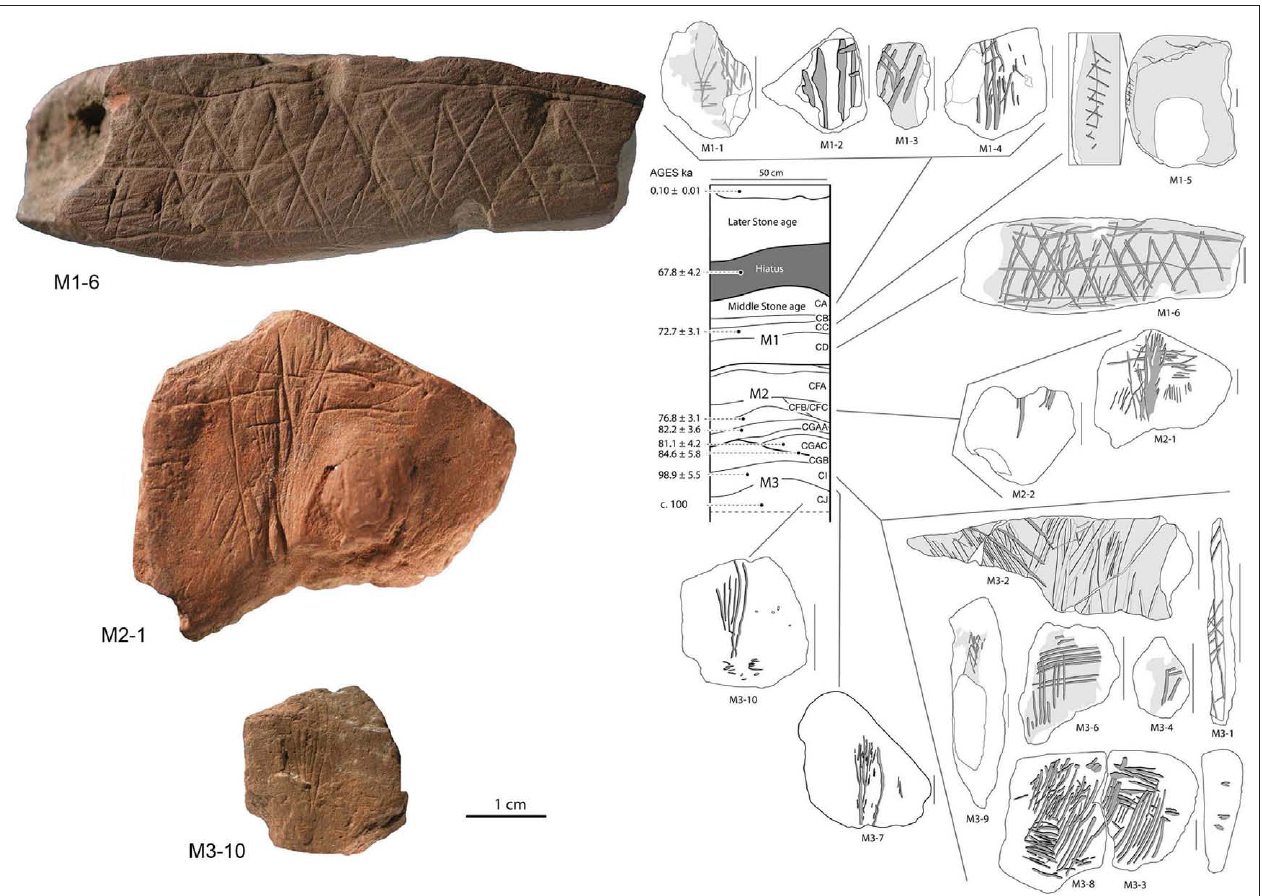
Figure 5 | Middle Stone Age engravings from South Africa. Photos and tracings of pieces M3-10, M2-1, and M1-6 from the Blombos Cave. In the drawing of the center is shown the stratigraphy and ages of Blombos Cave deposits. Adapted from Henshilwood et al. (2009).